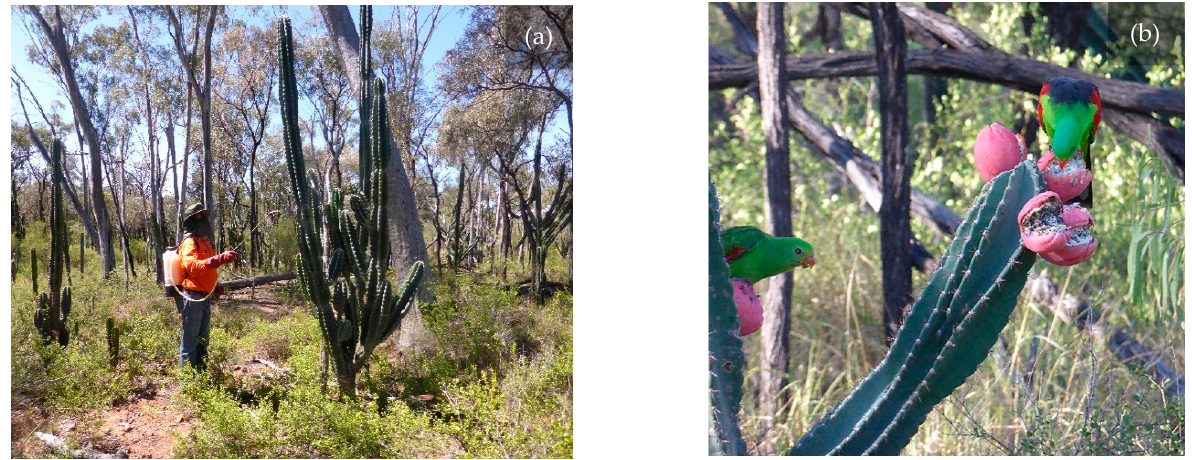
Figure 1. Cereus uruguayanus trial site showing: ( a ) foliar application of herbicide to a medium-density infestation; and ( b ) red-winged parrots ( Aprosmictus erythropterus ) feeding on C. uruguayanus fruit.